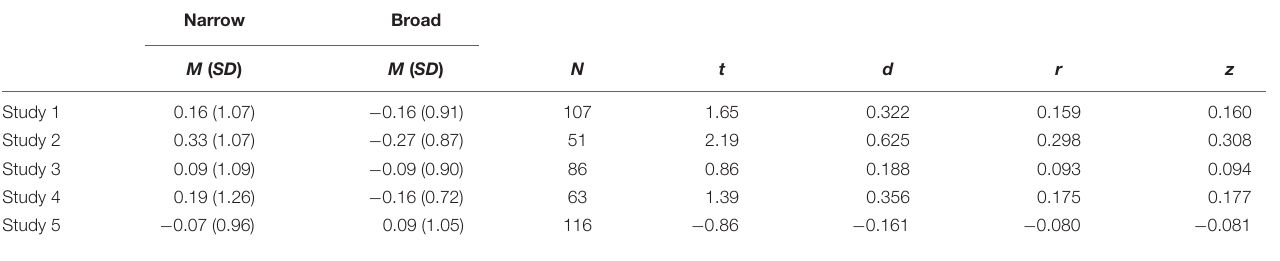
TABLE 9 | Meta-analysis of effect of cognitive scope condition on attitudes toward anger. Narrow